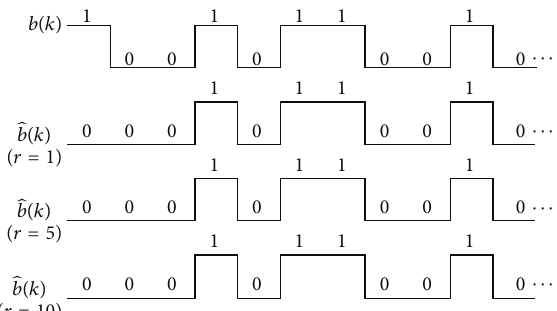
Figure 10: The recovered digital sequences for 𝑟 = 1 , 𝑟 = 5 , and 𝑟 = 10 , respectively, by the method of